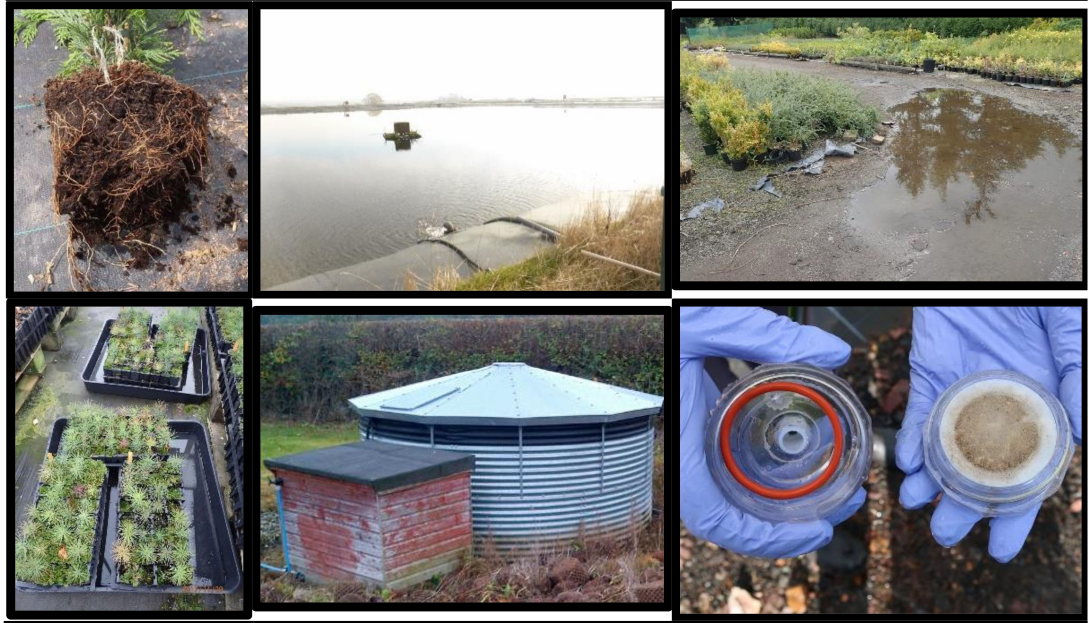
Figure 1. Fine-scale nursery sampling. Top, L-R: sampling roots of Chamaecyparis lawsoniana, irrigation reservoir, puddle. Bottom, L-R: water flow through sampling of Pinus sylvestris , water storage tank, filter after water